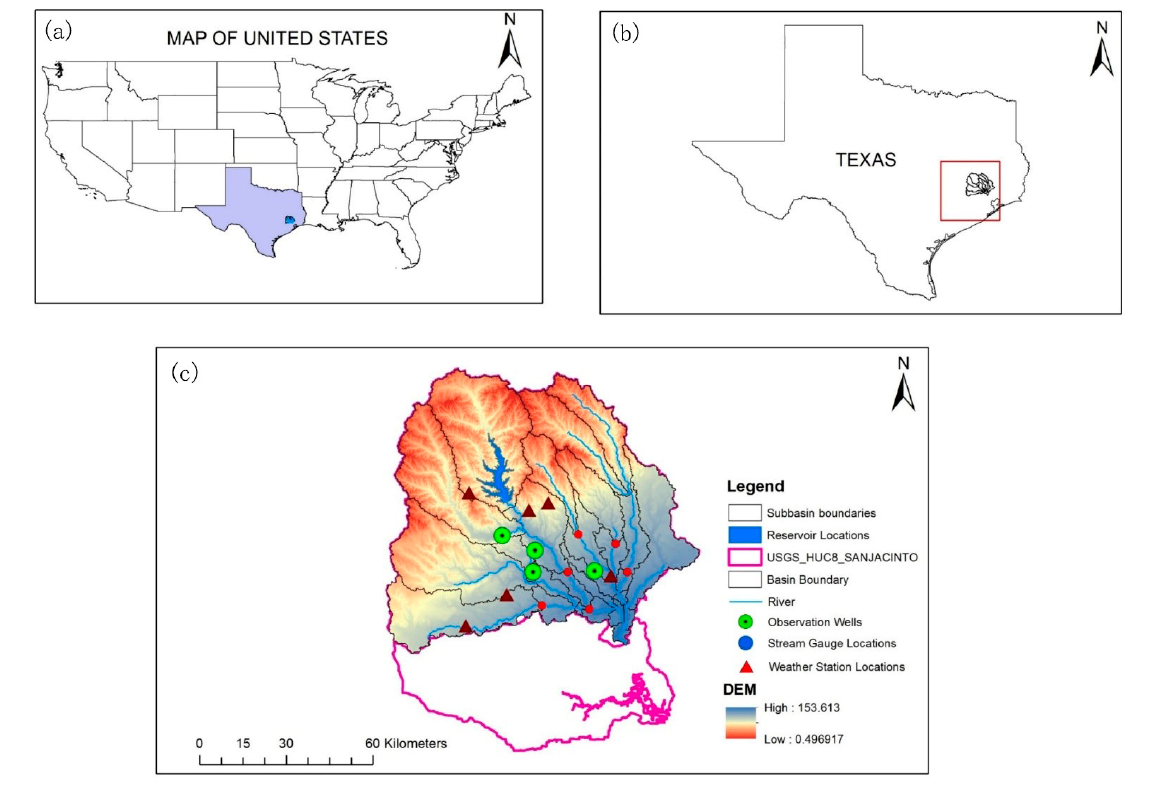
Figure 6. Location of study area ( a ) Inset map showing the location of San Jacinto River Basin in Unites States; ( b ) Inset map showing the location of San Jacinto River Basin in Texas; ( c ) Map of the study area showing the elevation, observation wells, stream flow gauging stations and weather stations.